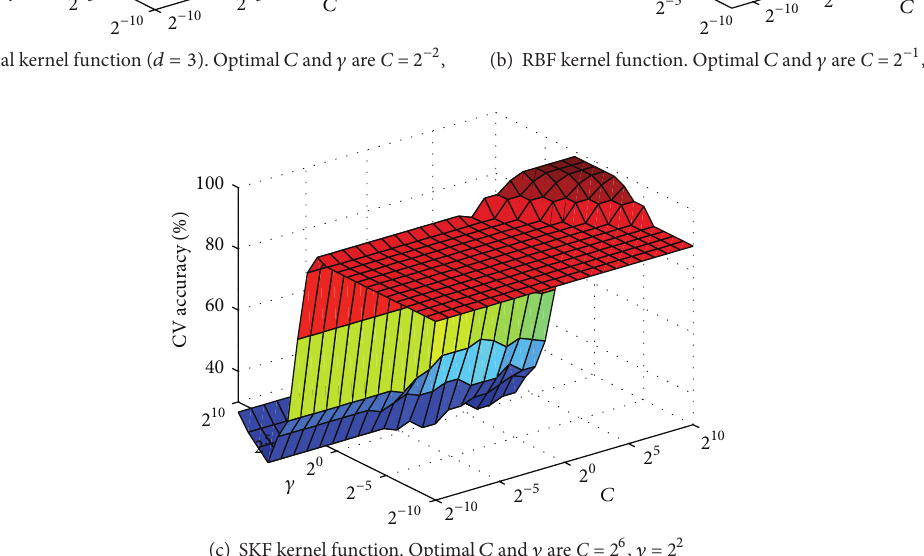
(c) SKF kernel function. Optimal 𝐶 and 𝛾 are C = 2 6 , 𝛾 = 2 2 Figure 7: CV accuracy with 𝐶 and 𝛾 for polynomial, RBF, and SKF kernel functions, in the second loading